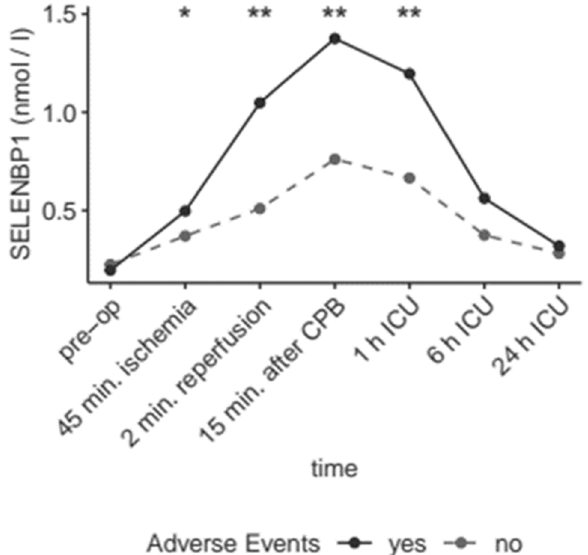
Figure 6. SELENBP1 before, during and after cardiac surgery in relation to outcome. Elevated serum SELENBP1 concentrations are associated with adverse events during the full course of surgery, especially directly after reperfusion, after weaning from the CPB, and shortly after arriving on the ICU. Adverse events comprise death, cerebral ischemia, bradycardia ( p = 0.033 for 45 min after induction of ischemia, p = 0.0051 for 2 min after reperfusion, p = 0.0011 for 15 min after weaning from the CPB, and p = 0.0017 for 1 h after arrival on the ICU) (AUC; 0.8). **; p < 0.01, *; p < 0.05.